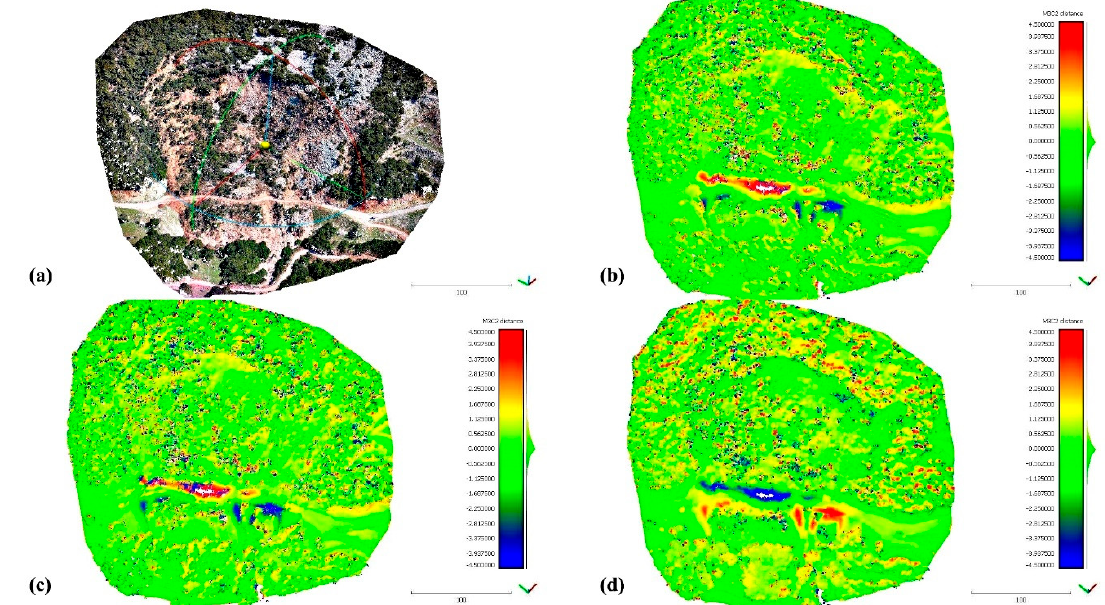
Figure 21. ( a ) The point cloud derived from a UAV flight on 13 April 2017. ( b ) M3C2 distances in x axis calculated between the point cloud of 13 April 2017, and the respective point cloud of 23 December 2020. ( c ) M3C2 distances in y axis and ( d ) M3C2 distances in z axis, respectively.